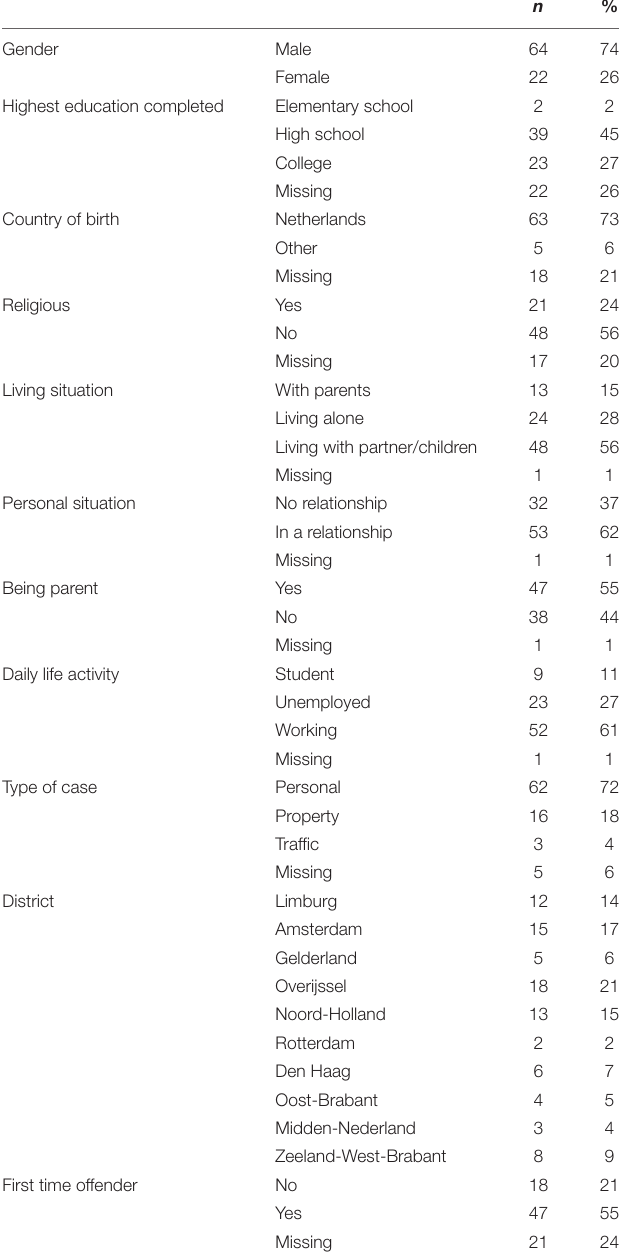
TABLE 2 | Number of participants per measurement, distributed by n